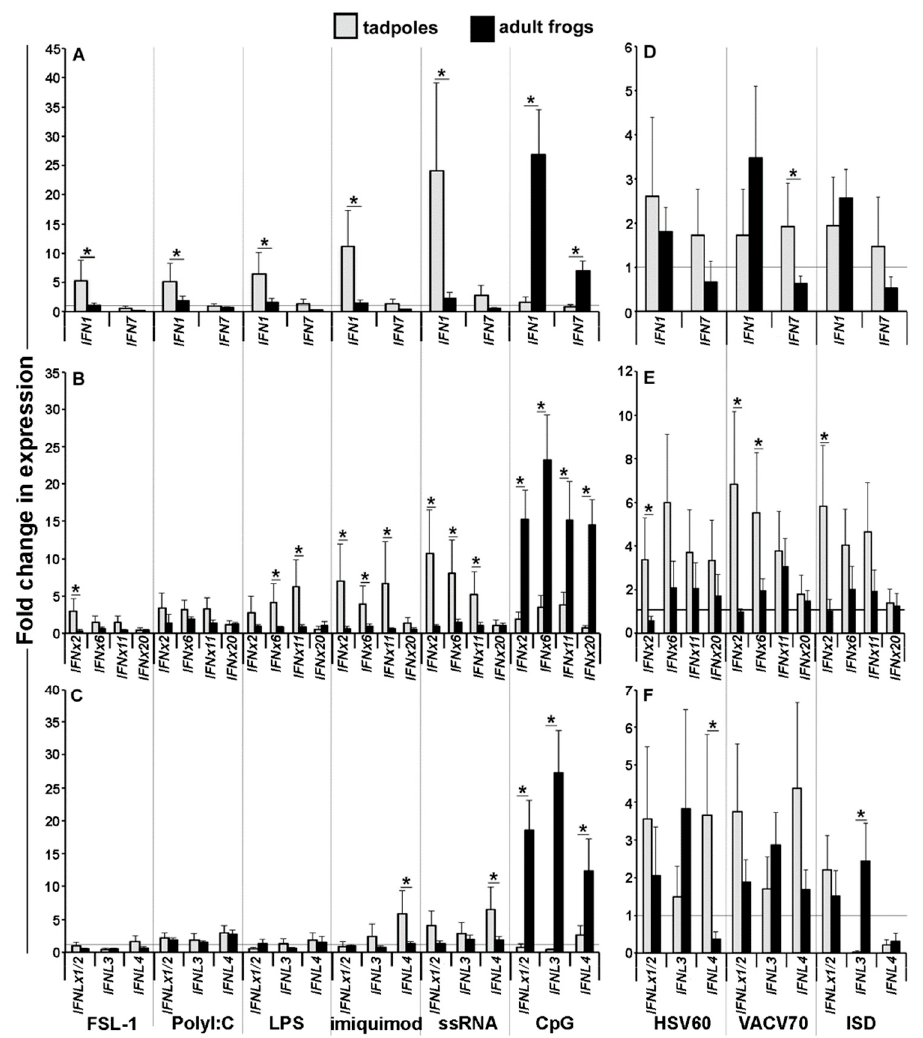
Figure 3. Tadpoles and adult frog kidney cells mount distinct IFN responses to PAMP stimulations. Tadpoles (NF 54, N = 5) and adult frog (1 year old, N = 5) skin cells were isolated and stimulated with a panel of PAMPS for 6 h, and the IFN gene expression was examined. ( A ) IFN1 and IFN7 ; ( B ) IFNx2 , IFNx6 , IFNx11 , and IFNx20 ; ( C ) IFNLx1/2 , IFNL3 , and IFNL4 gene expression following stimulation with TLR and RIGI-specific PAMPs. ( D ) IFN1 and IFN7 ; ( E ) IFNx2 , IFNx6 , IFNx11 , and IFNx20 ; ( F ) IFNLx1/2 , IFNL3 , and IFNL4 gene expression following stimulation with CDS agonists. All of the gene expressions were compared to the GAPDH control, normalized against the mock-infected expression of the respective genes within the given tissues. All of the results are presented as means + SEM. Significant differences between the respective experimental groups are denoted by overhead lines and asterisks (*). p < 0.05.